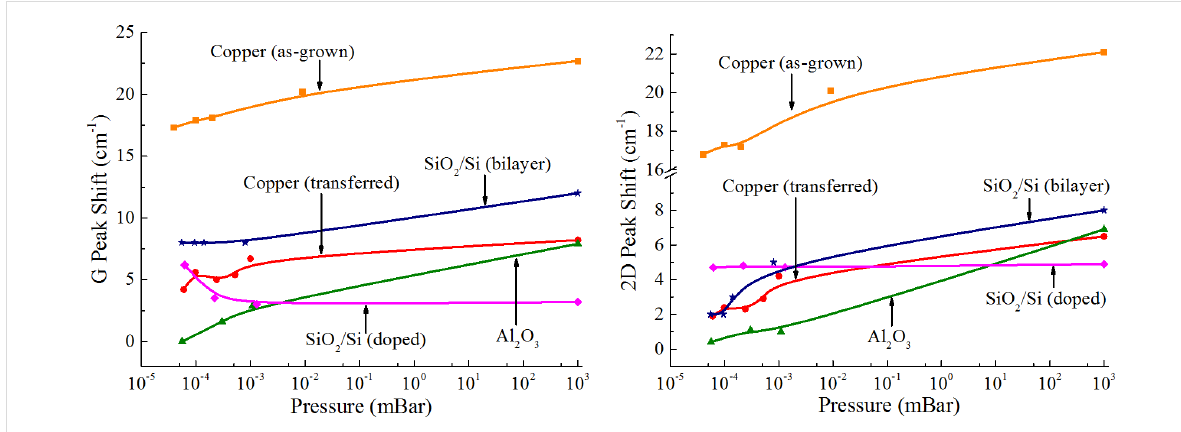
carrier density [13]. After the atmosphere was returned to that of the pressure-controlled box, the spectra parameters gradually changed back to their initial values over a period of up to four days of air